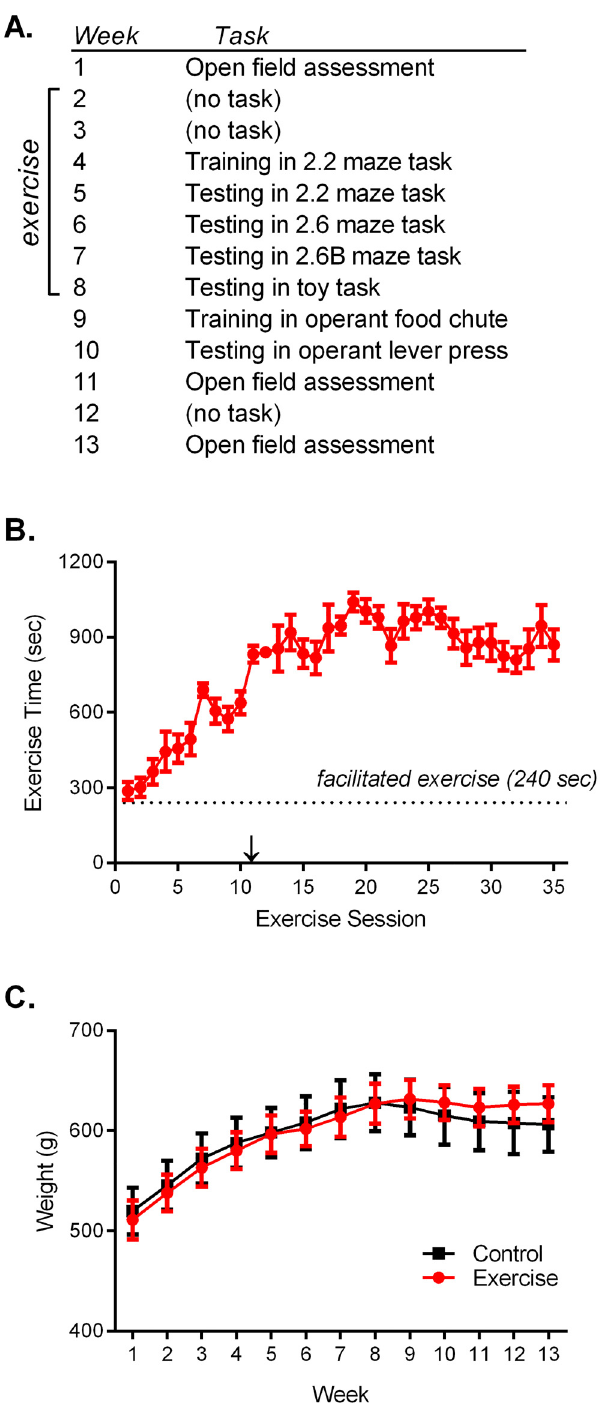
Fig 1. Thirteen Week Study. A) Outline of the study. In Weeks 2 – 8, Exercise rats were placed in a rodent running ball for five 20 min sessions/week. B) Each 20 min exercise session involved 4 min of facilitated running and 16 min of voluntary, free running. An arrow indicates the onset of testing tasks in Week 3. C) Individually calculated food rations ensured that body weights remained similar between groups. Data are shown as mean ± SEM; for each group n =